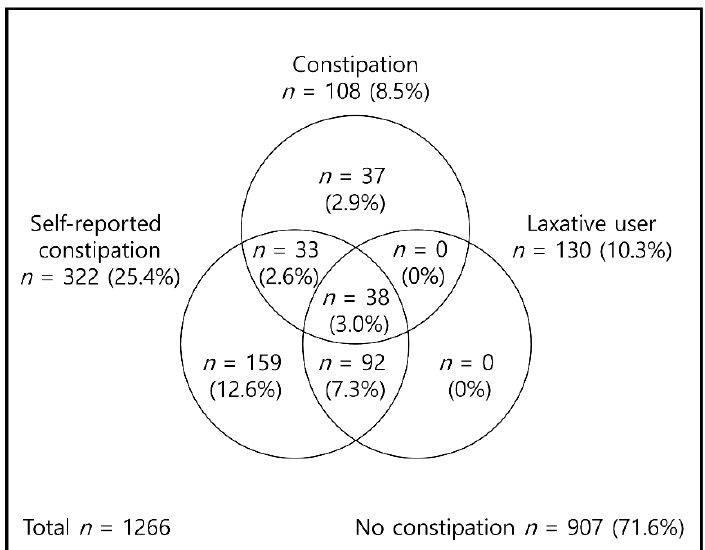
Figure 1. Prevalence of clinically defined constipation, self-reported constipation, and laxative use.